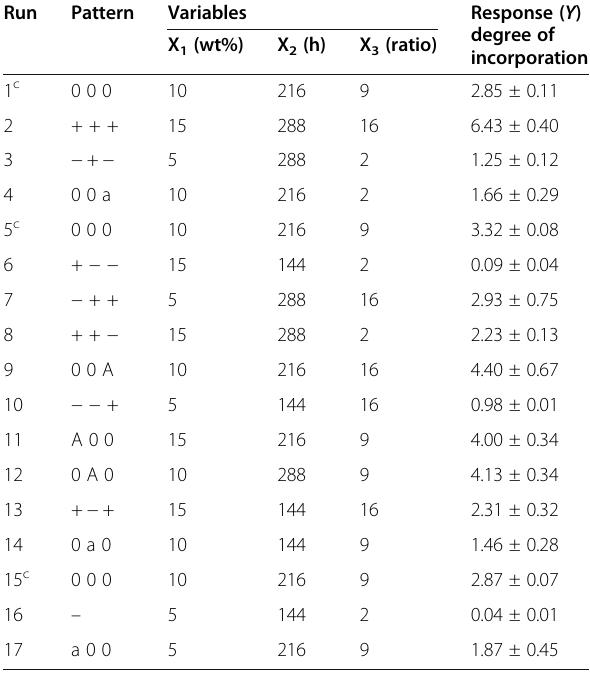
Table 3 Central composite design and response for the enzymatic synthesis of mono- and dioleyl p -coumarates